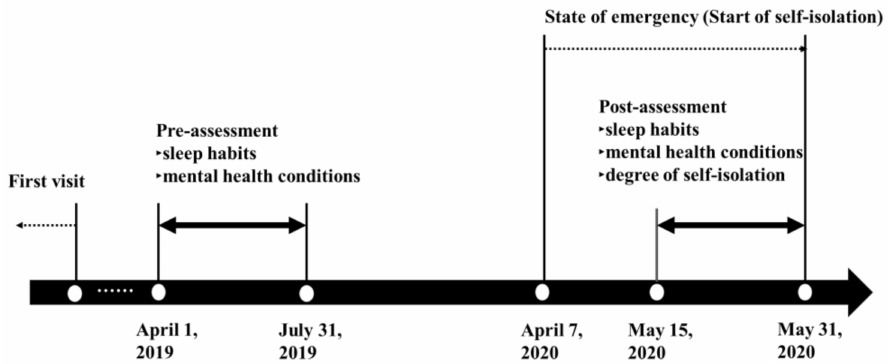
Figure 2. A period of self-isolation during the COVID-19 pandemic and timeline of the